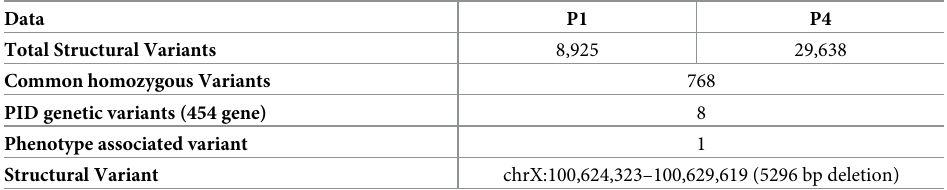
Table 2. Whole genome sequencing structural variant analysis for P1 and